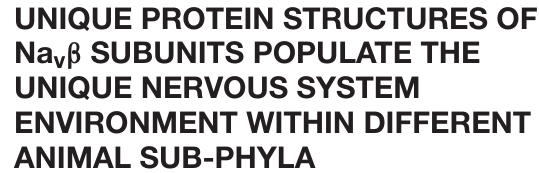
# References for the Table contents are populated within the text. ∗ Ca v subunits are small ∼ 35 kDa proteins with four transmembrane segments which are not included in this table since they are only identifiable in vertebrates, and are optional subunits.